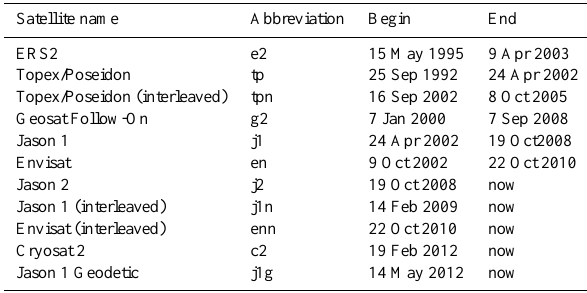
Table 3. Name, abbreviation and period of SLA measurement for all satellite used by the assimilation